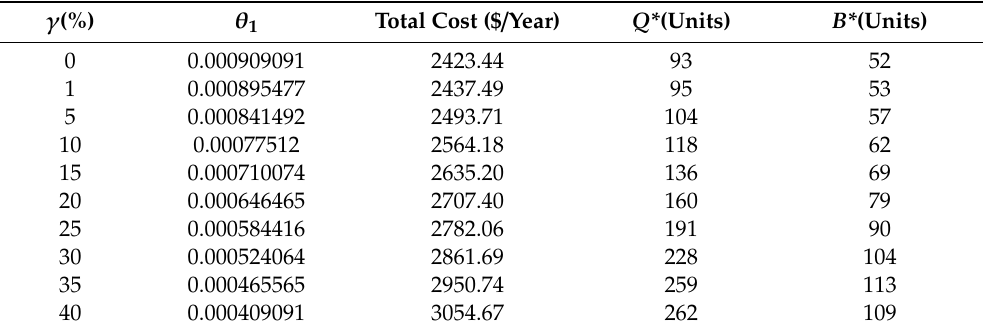
Table 2. Change in optimal lot size and backorder quantity with variation in the defective rate (Example